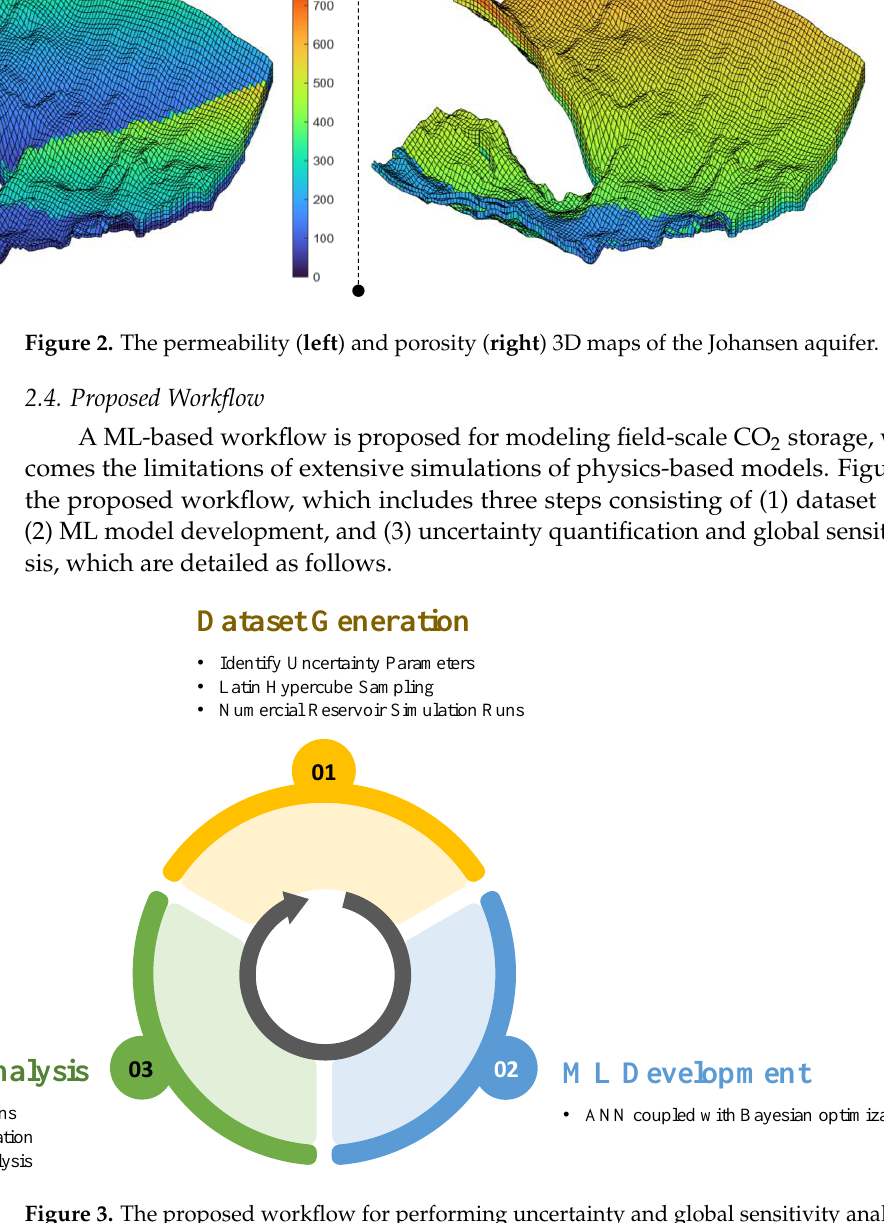
Figure 3. The proposed workflow for performing uncertainty and global sensitivity analysis for CO 2 Storage in a saline aquifer.